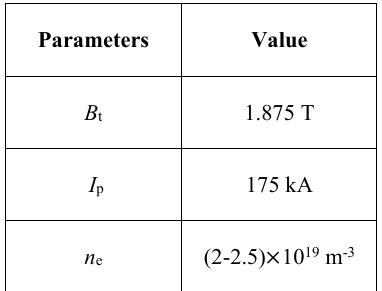
Table 5 . Main plasma parameters of shot